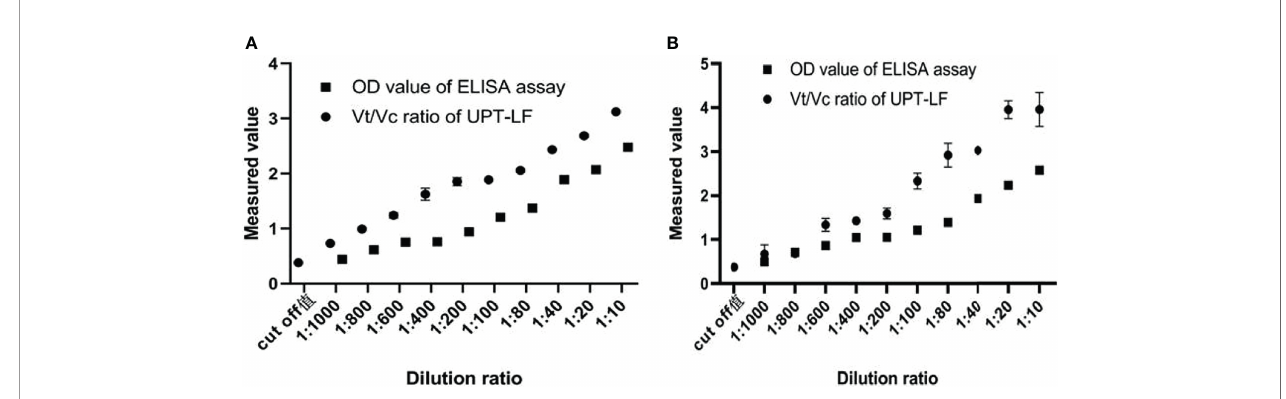
FIGURE 2 | (A) TSOL18 and (B) GP50, the up-converting phosphor technology-based lateral- fl ow (UPT-LF) assay is more sensitive than the enzyme-linked immunosorbent assay (ELISA), and the value of Vt/Vc is still higher than that of cut off when diluted 1000